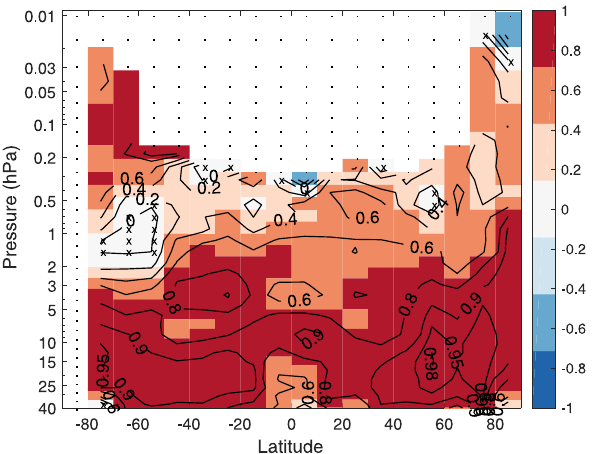
Figure 11. NO 2 mixing ratio 5-day time series at two pressure levels from the Arctic 60–90 ◦ N and the Antarctic 60–90 ◦ S. The colour coding symbols: W/S and W/N are WACCM in Antarctic Arctic; G/S and G/N are GOMOS in Antarctic, Arctic.